Question: Express in one sentence what the figure is showing.
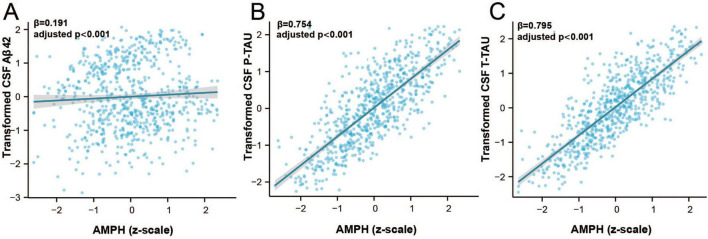
Answer: Associations between baseline CSF AMPH and core CSF biomarkers. CSF AMPH levels were positively associated with CSF Aβ 42 (A) , P-tau (B) , and T-tau (C) . The normalized regression coefficients (β) and P -values were derived from multiple linear regression adjusted for age, sex, education, baseline diagnosis, and APOE ε4 status. Abbreviations: CSF, cerebrospinal fluid; AMPH, amphiphysin-1; P-tau, phosphorylated tau; T-tau, total tau; Aβ 42 , amyloid-β42; APOE, Apolipoprotein E.